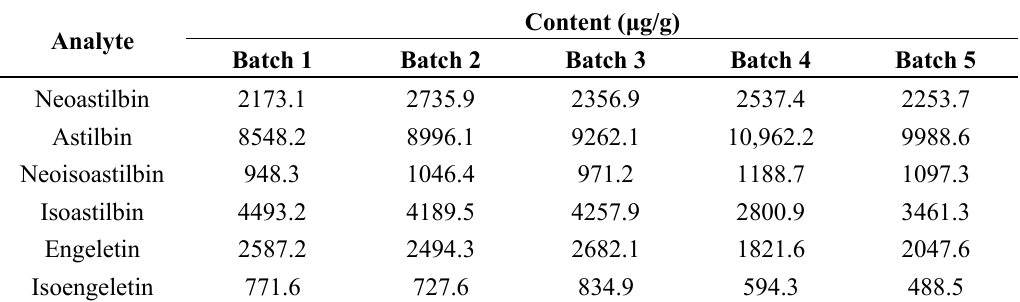
Table 3. Contents of the six compounds in different batches of Smilacis glabrae